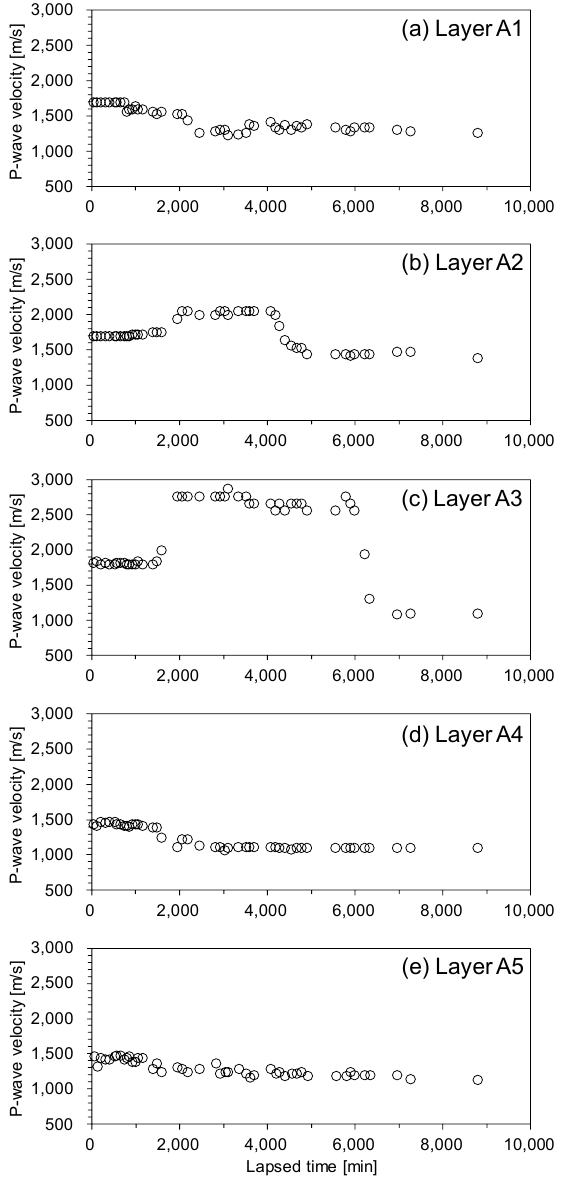
Figure10. P-wavevelocityoftheunconsolidatedsedimentsampleduringdepressurization. ( a )layerA1, Figure 10. P-wave velocity of the unconsolidated sediment sample during depressurization. ( b ) layer A2, ( c ) layer A3, ( d ) layer A4, ( e ) layer ( a ) layer A1, ( b ) layer A2, ( c ) layer A3, ( d ) layer A4, ( e ) layer A5.